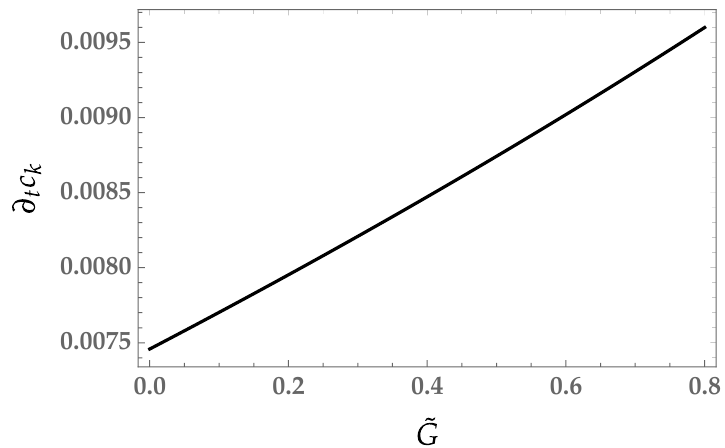
Figure 5. The beta function β c = ∂ t c k in the order ∂ 4